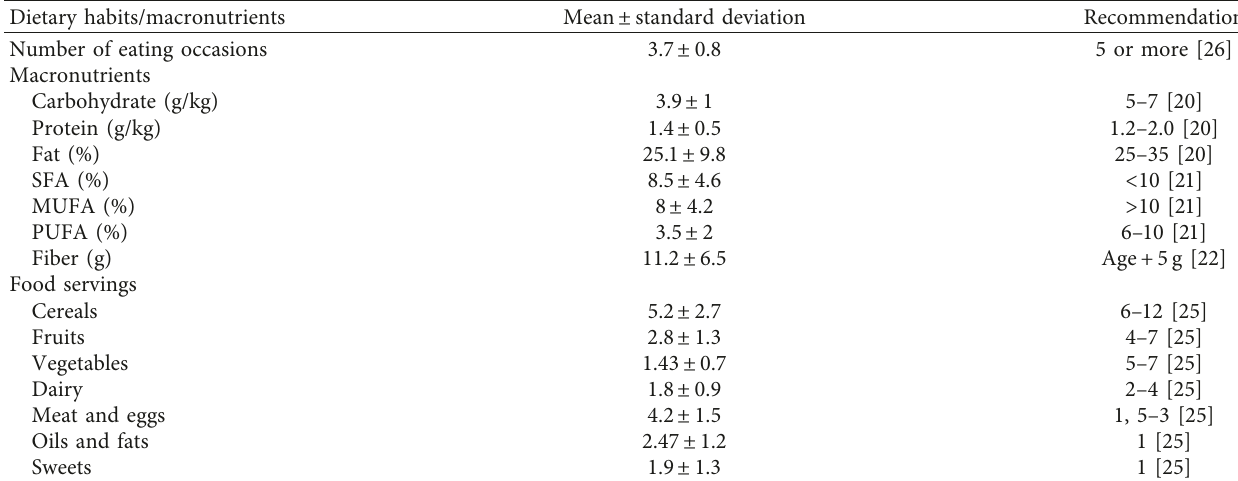
Table 1: Dietary habits and macronutrient intake of the athletes ( n